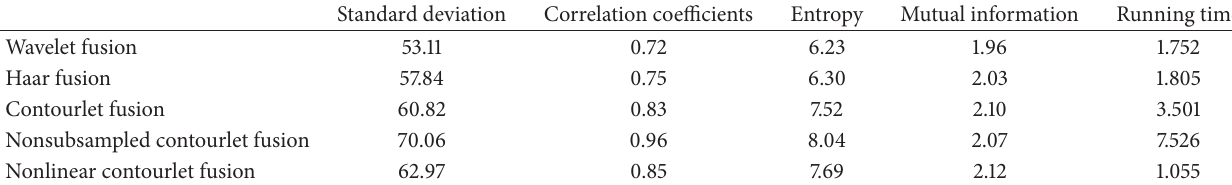
Table 5: Index of performance evaluation.